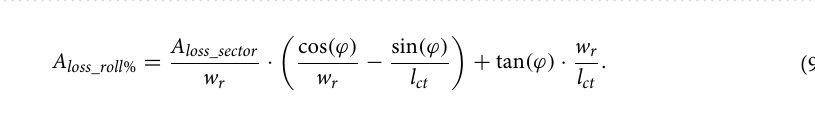
Figure 10. Design approach for the definition of the 2-dimensional screen architecture. In order to reach a desired printed finger width w f , a series of design choices has to be made. First, the screen opening width w n needs to be derived by rheological investigation of the paste at the desired printing speed and determination of the expected spreading offset. Furthermore, the margin for the SUI (e.g. SUI min > 1.25), the smallest available wire diameter for mesh production and the desired screen tension γ screen are defined. After calculating the mesh count MC by Eq. (3), the SUI min requirement is controlled. Depending on the result, the screen angle φ is chosen by minimizing the cutting losses, defined by Eq. (9). If no configuration is available which fulfills all requirements, new wire materials need to be